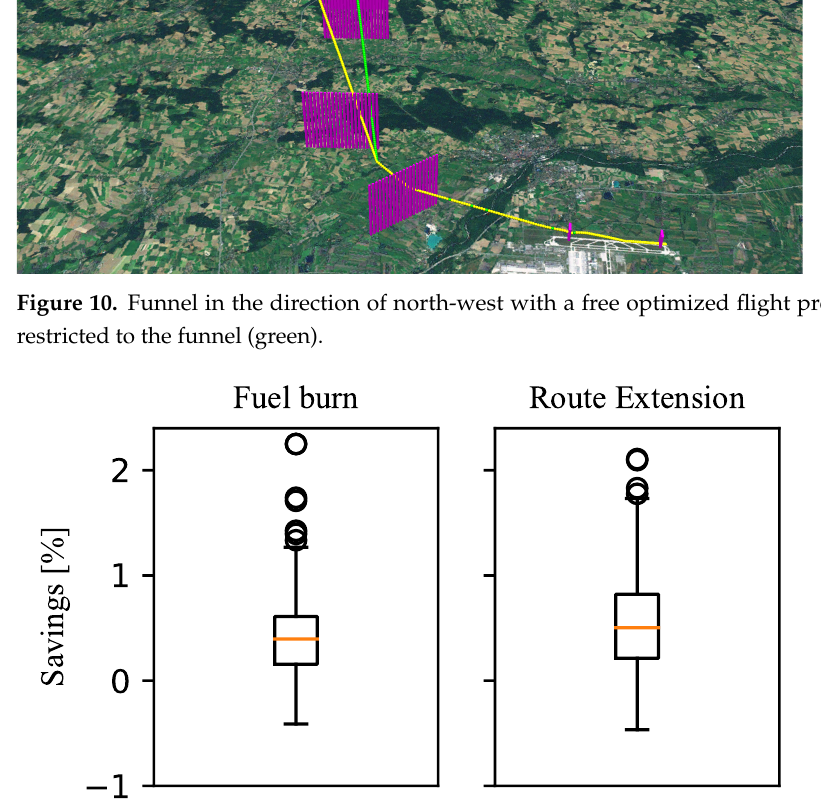
Figure 11. Boxplot of flight efficiency (fuel burn, ground distance route extension) as the result of a transition from ADS-B to optimized calculated departure